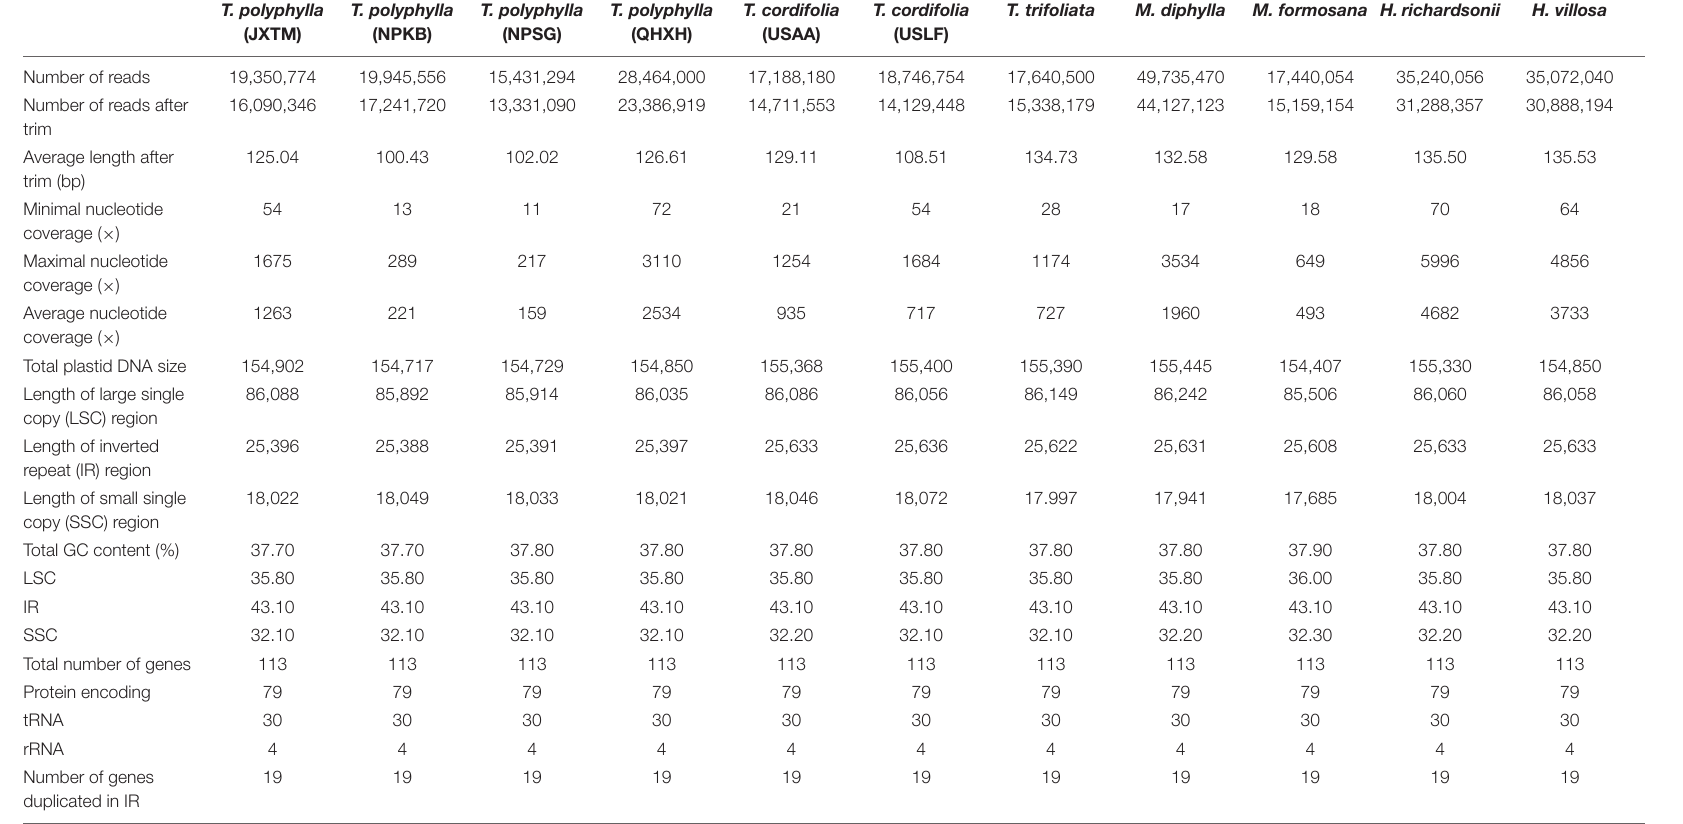
TABLE 2 | Summary of the 11 individuals from the Heuchera group sequenced in this